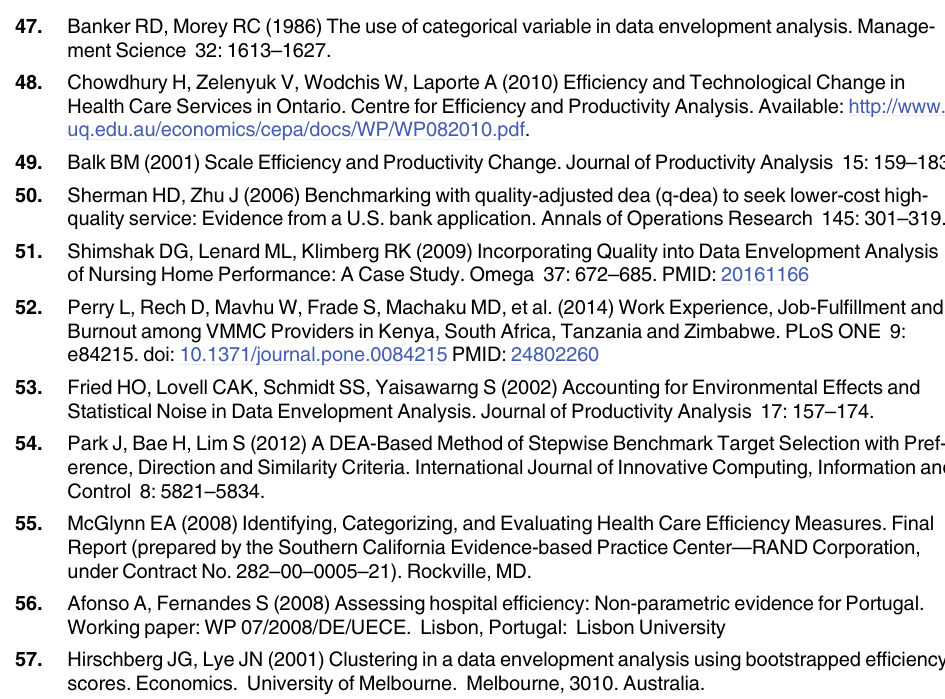
PLOS ONE | DOI:10.1371/journal.pone.0118152 February 23,